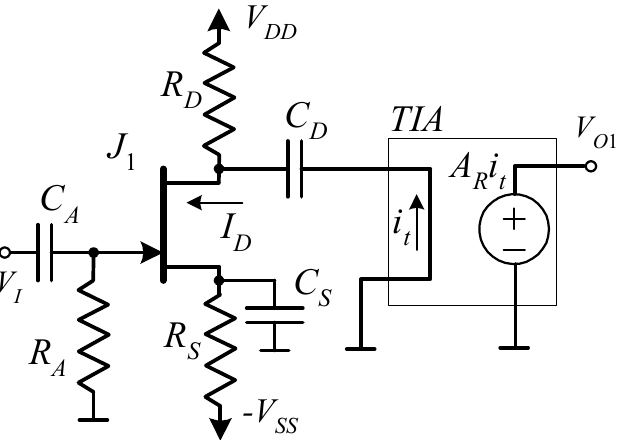
Figure 1. Reference schematic of a JFET CS stage-based amplifier. The second stage (transimpedance amplifier (TIA)) represents the idealized behavior of an operational amplifier-based transimpedance amplifier with gain A R